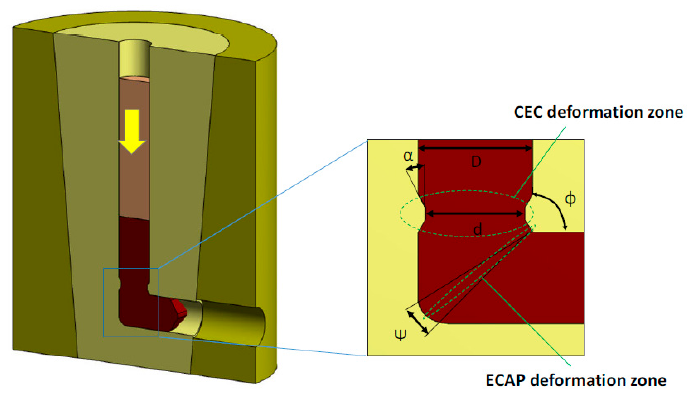
Figure 10. Schematic illustration of the CECAP process [37].